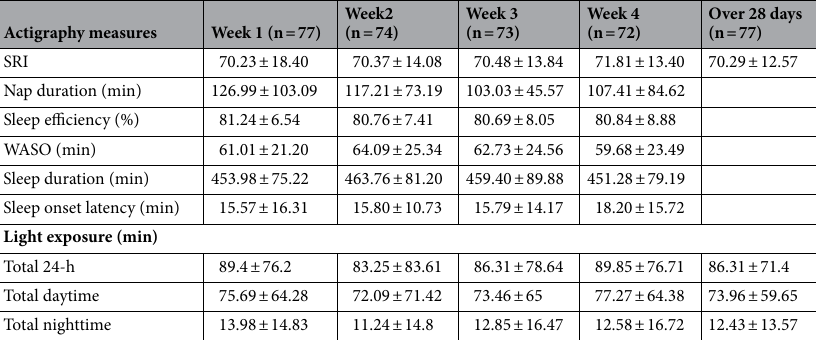
Table 2. Actigraphy based sleep and light exposure variables. Data presented as Mean ± Standard Deviation. Light exposure is number of epochs (minutes) with ≥ 250 lumen over time interval. Daytime corresponds to the interval 10AM to 9:59PM; nighttime corresponds to the interval 10 PM to 9:59 AM.